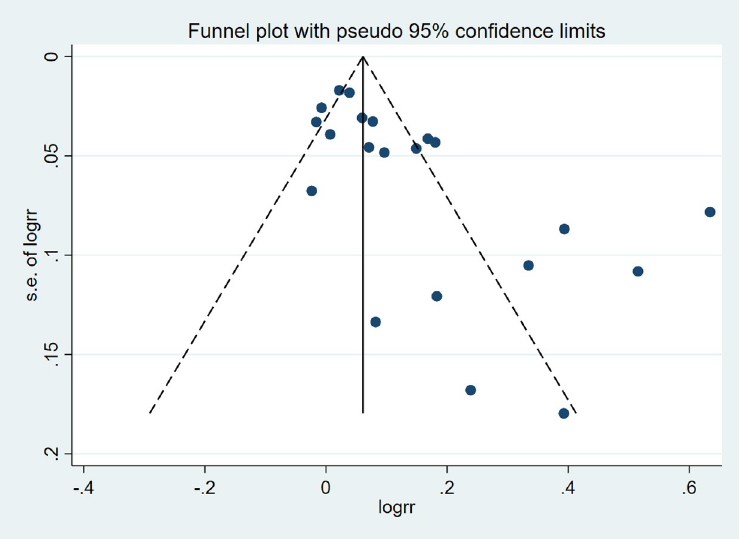
Fig 5. Funnel plot comparing the effects of supplementary education based on traditional education and traditional education alone on the adequate bowel preparation rate.